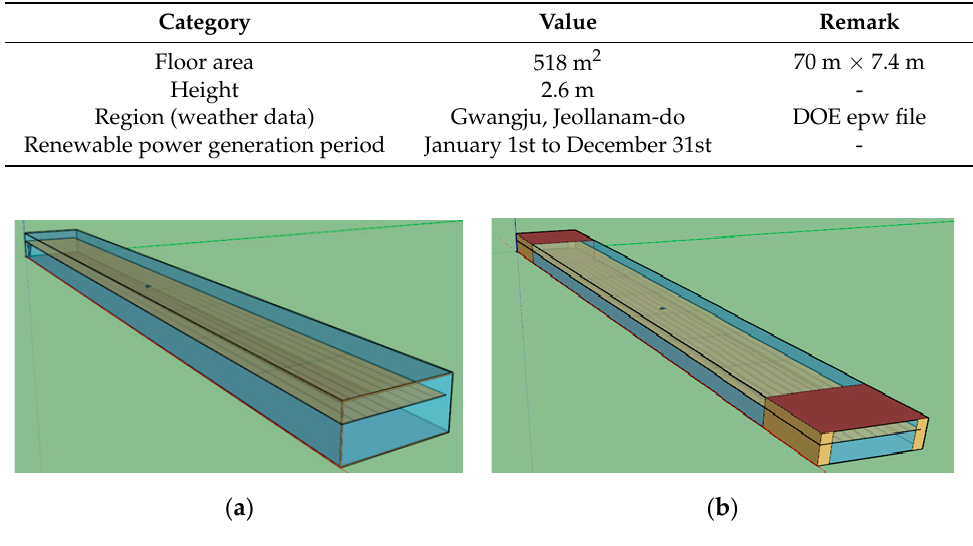
Figure 1. Case geometry for simulation ( a ) Case 1, ( b ) Cases